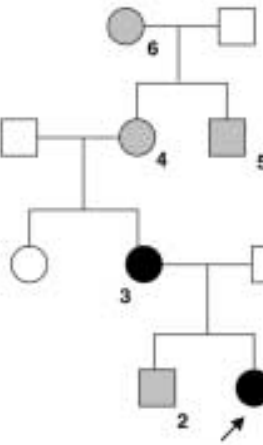
Figure 1 Family tree with unaffected subjects shown in white, clini- cally affected sub- jects shown in grey, and subjects geneti- cally diagnosed with MODY 2 shown in black. The arrow points to the index